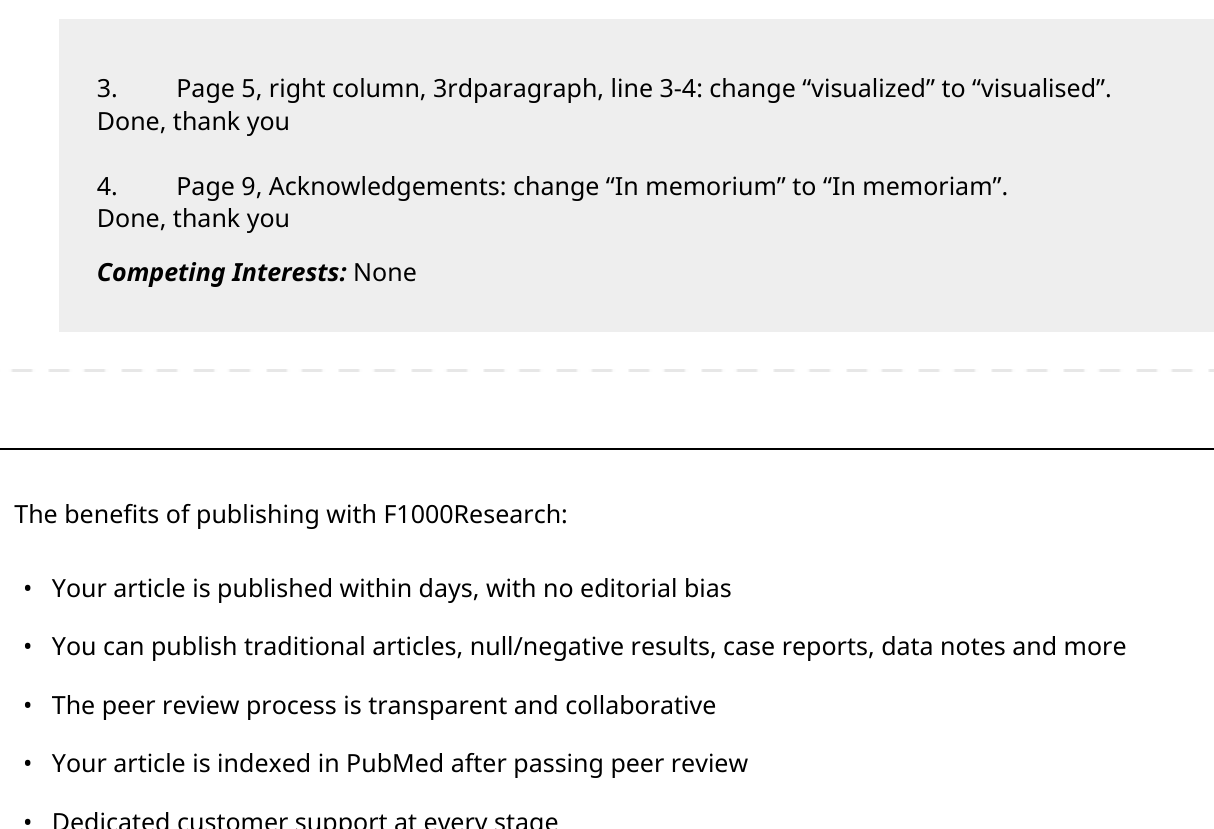
Page 5, right column, 3rdparagraph, line 3-4: change “visualized” to